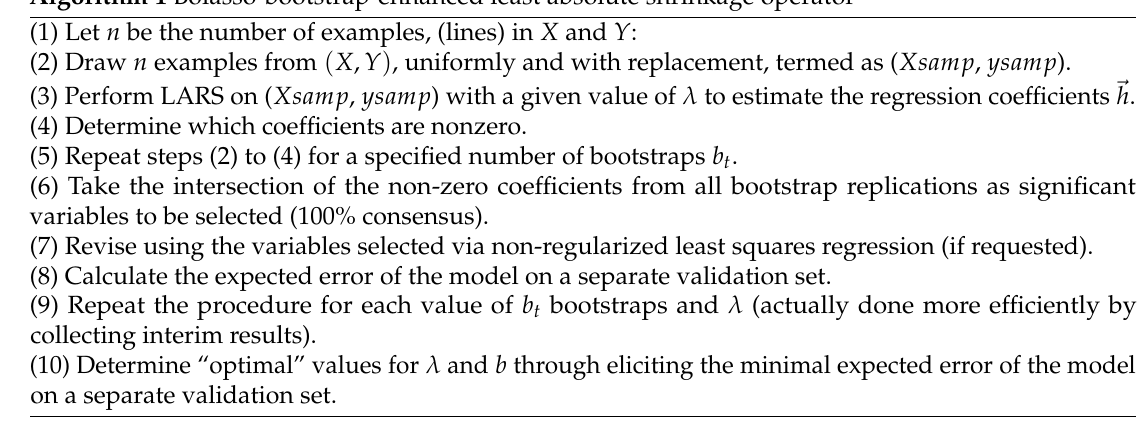
Algorithm 1 Bolasso-bootstrap-enhanced least absolute shrinkage